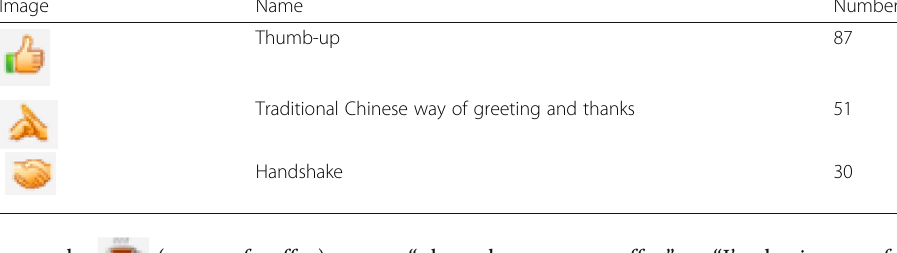
Table 5 Top 3 most frequent Emoji as backchannel device Image